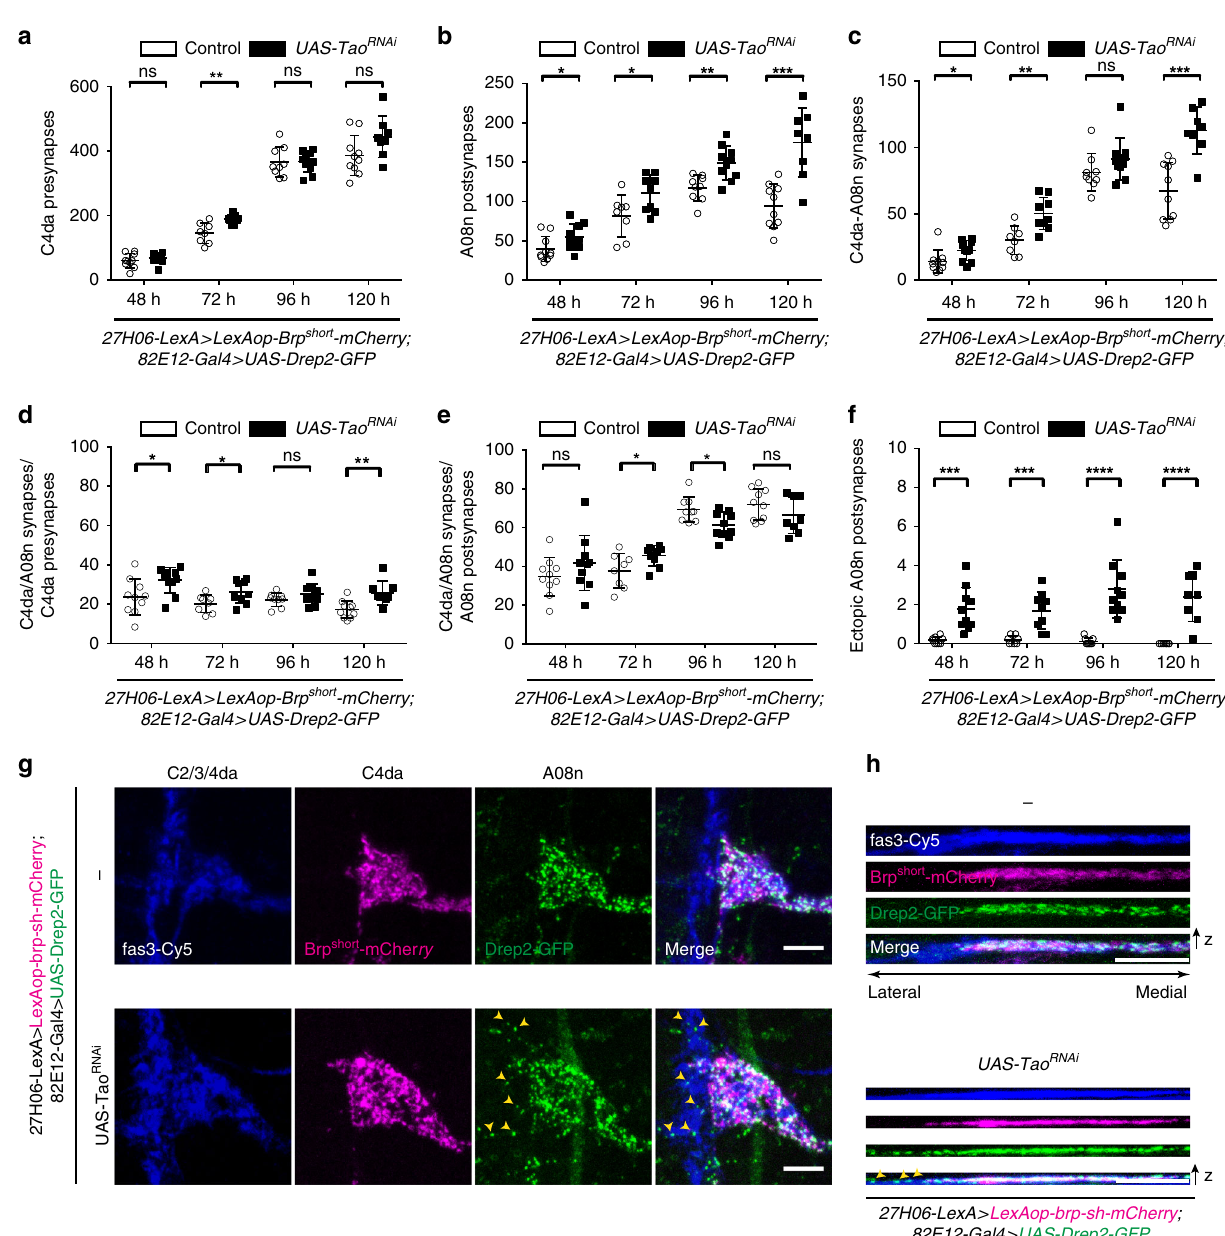
Fig. 4 Tao restricts postsynaptic growth and connectivity during larval development. a – c Quantitative analysis of C4da – A08 neurons synaptic pro fi les from 48 h AEL to 120 h AEL in control or with Tao RNAi expression in A08n neurons. a C4da neuron presynapse, b A08n postsynapse, and c C4da – A08n